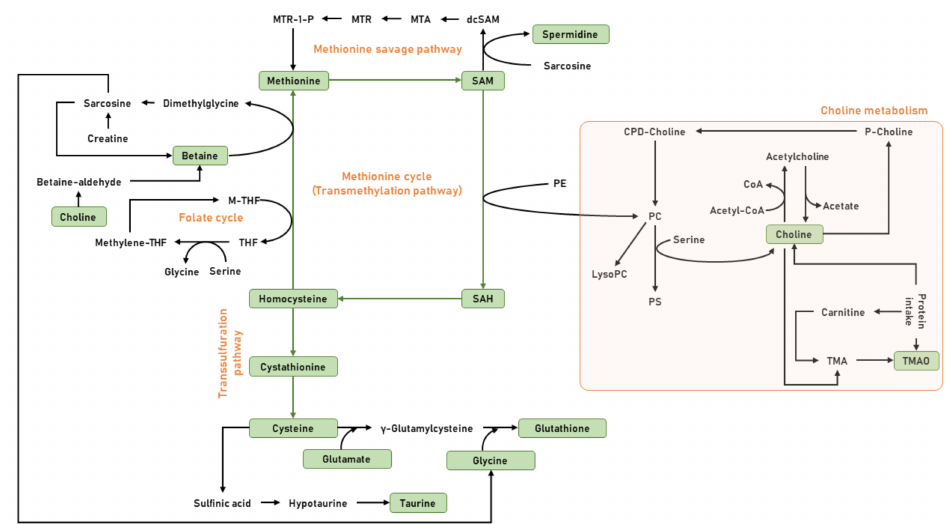
Figure 1. General view of the one-carbon metabolism. Choline, an essential micronutrient, can be obtained from exogenous sources—for instance, from foods such as eggs, beans, fish, nuts, seeds, and whole grain-, and from endogenous biosynthesis. The de novo synthesis of choline is catalyzed by the enzymatic activity of phosphatidylethanolamine-methyltransferase (PEMT) via the sequential methylation of PE, using S-adenosylmethionine (SAM) as a methyl donor. The oxidation of choline into its metabolite betaine by choline oxidase plays a role in the formation of methionine and SAM, methyl-donors that are involved in methylation pathways. SAM is considered the main methyl-donor for histone methyltransferases (HMTs) and DNA methyltransferases (DNMTs), key enzymes